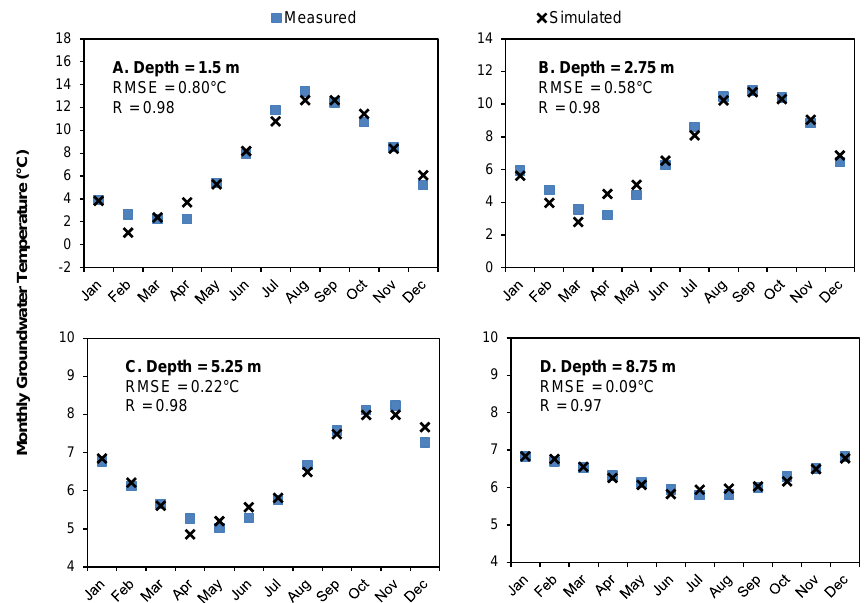
Fig. 9. Comparison of observed and simulated monthly groundwater temperature at different depths: (A) 1.5, (B) 2.75, (C) 5.25, and (D) 8.75m. The y axes are not all drawn to the same scale.